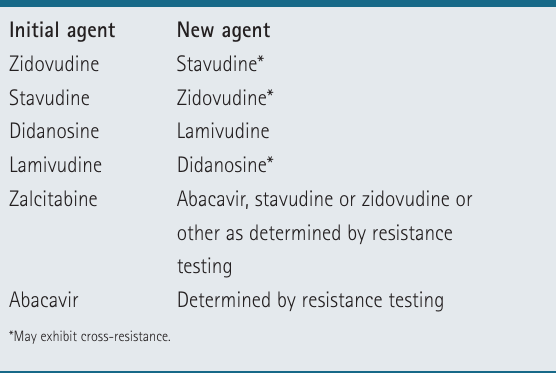
TABLE XIV. CHANGING NRTI S IN THE PRESENCE OF